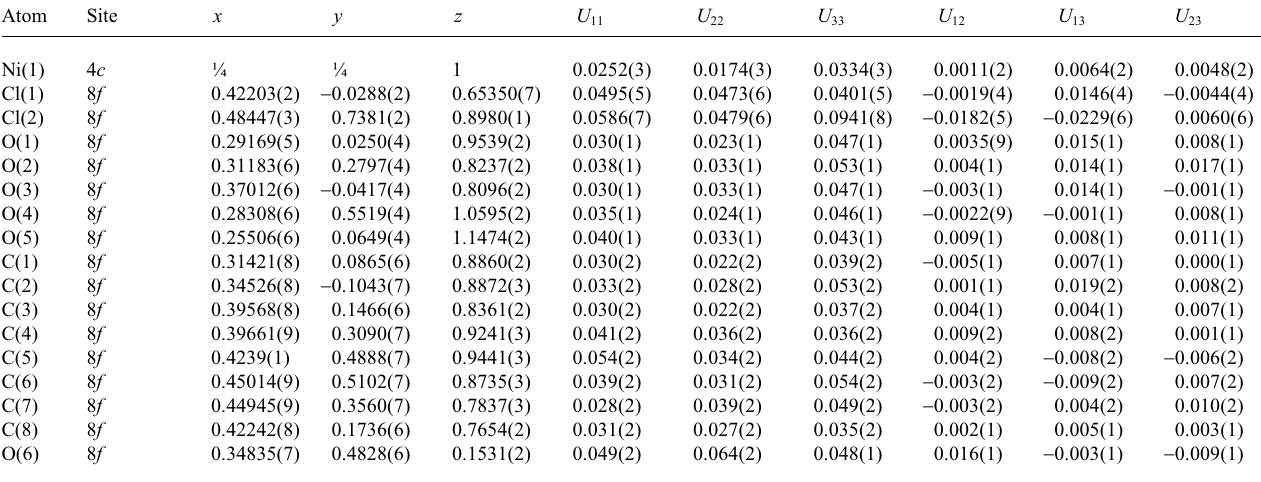
Table 3. Atomic coordinates and displacement parameters (in Å 2